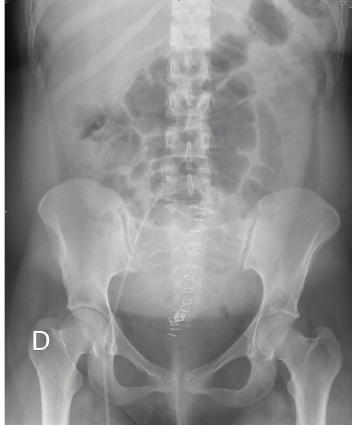
Figure 3: Abdominal X-ray on day three after cesarean